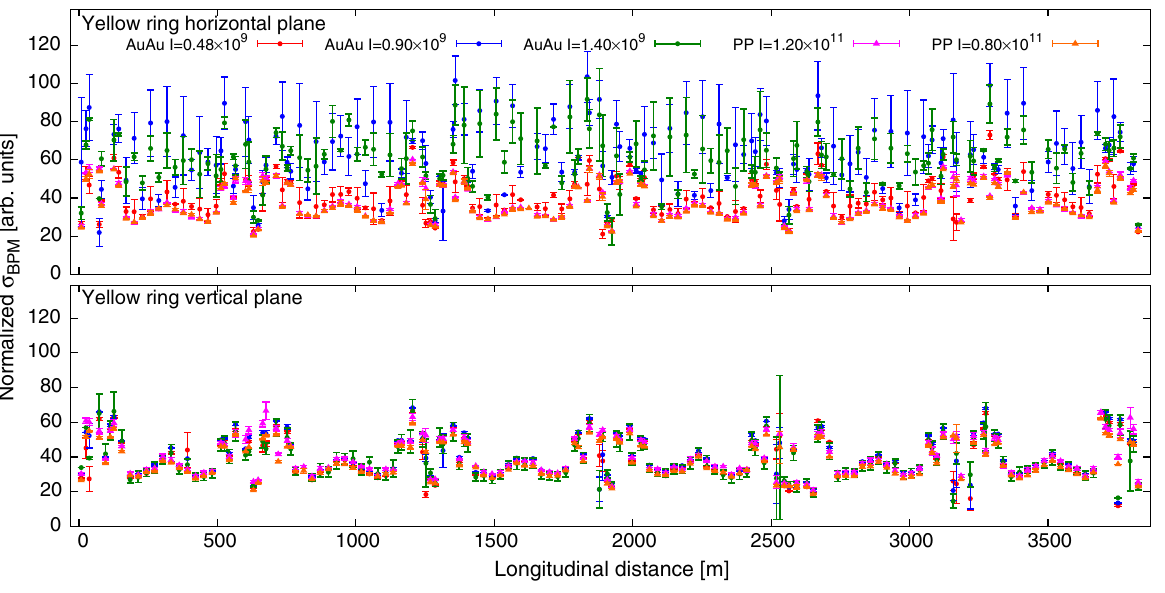
FIG. 6. Estimated noise in Fig. 4 normalized to the ratio of BPM aperture to beam charge (at 1 × 10 9 gold ion or 0 . 79 × 10 11 protons). Error bars reflect statistical standard deviations of estimated noise over three sets of experimental data.